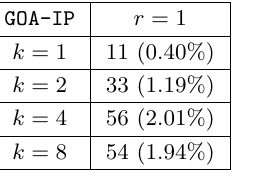
Table 2 Number of instances timed out by the exact solvers after ten